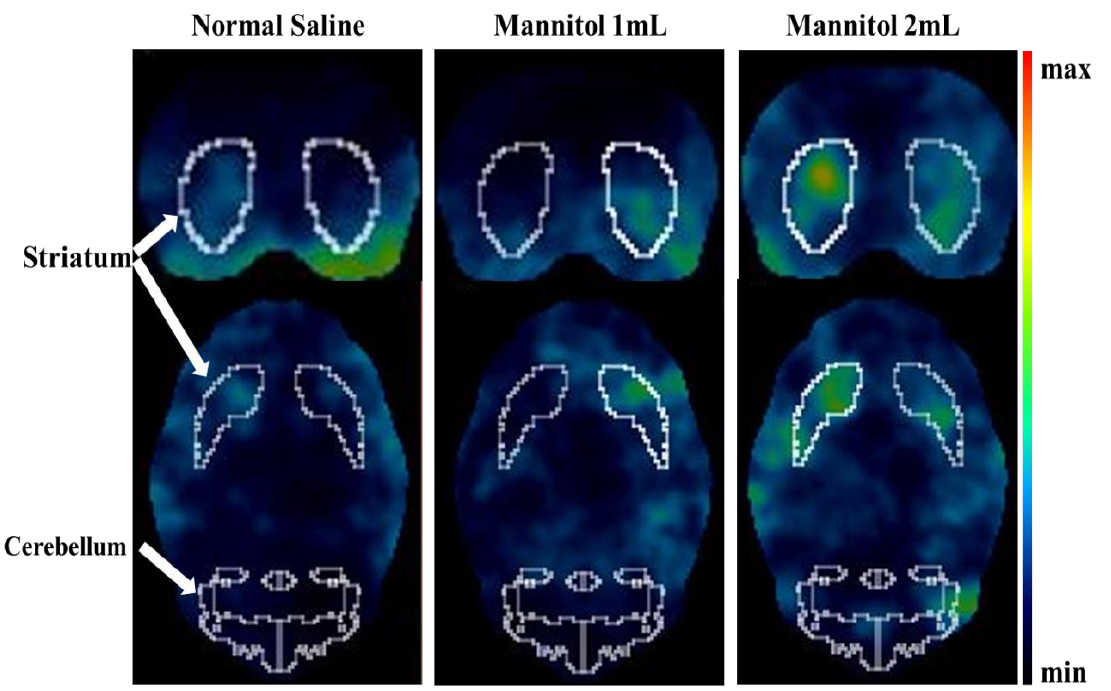
Figure 3. Representative static coronal and transverse NanoSPECT/CT imaging in the control, 1 mL, and 2 mL of 20% mannitol pre-treated rats at 75-90 min post- [ 99m Tc]Tc TRODAT-1 injection, respectively ( n = 5, each). The striatal specific binding ratios in the three groups were 0.90 ± 0.44, 1.19 ± 0.10, 1.64 ± 0.38,